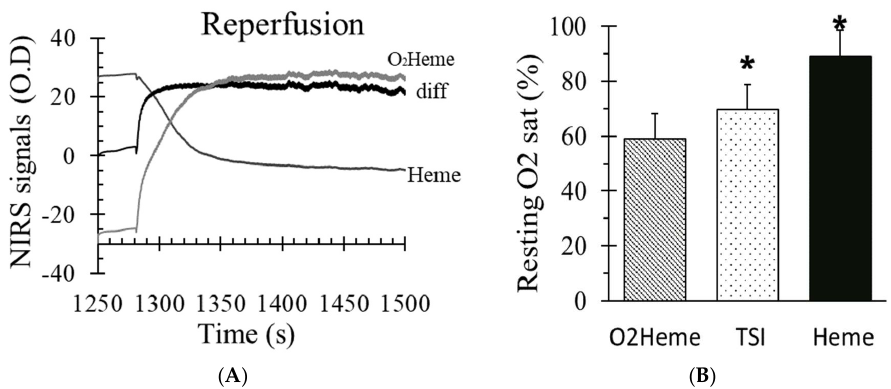
Figure 2. ( A ) The O 2 heme and Heme signals during reactive hyperemia and the difference in both signals which indicated the influence of blood volume change. ( B ) The percent of oxygen saturation at rest from three different methods of calculating oxygen saturation (O 2 heme, tissue oxygenation / saturation index (TSI), and Heme). * indicates a significant di ff erence in the method of calculating oxygen saturation ( p < 0.01 for the three comparisons). Values are means ±